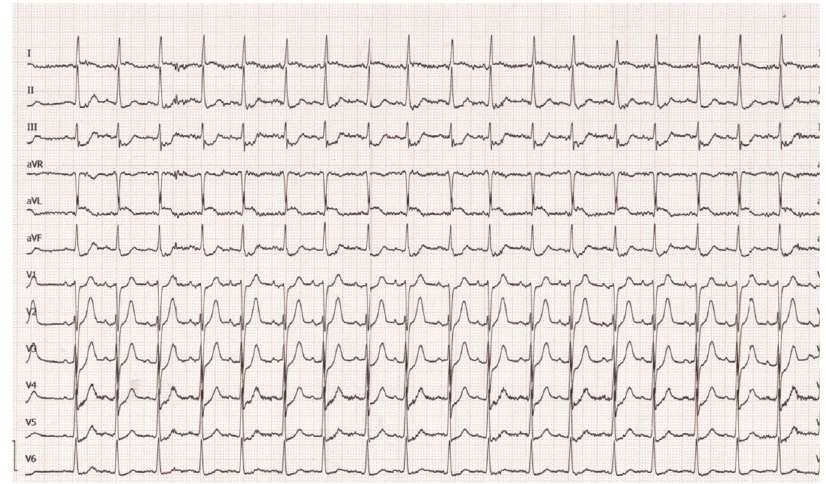
Figure 1: Initial ECG recording showing signi fi cant ST-segment elevations in leads I and aVL and corresponding ST-segment depressions in II, III, and aVF.